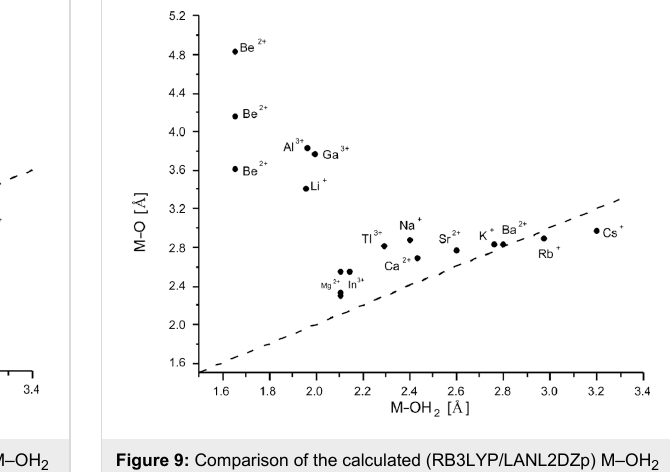
Figure 7: Comparison of the calculated (RB3LYP/LANL2DZp) M–OH 2 and M–O coordinating distances for [2.2.bpy] (dashed line: bisecting line; for the data see Table 7).